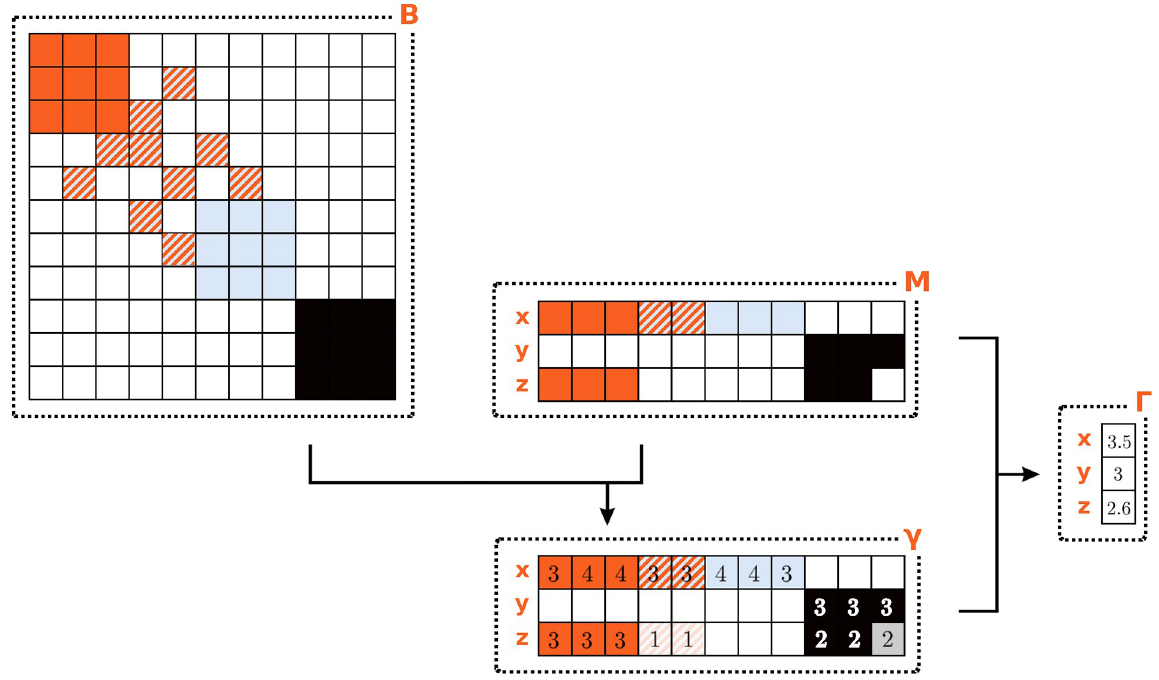
Fig 6. Example 2. A graphical representation of two stylized B and M matrices alongside the Coherent Diversification of the associated firms. See text for a detailed calculations.